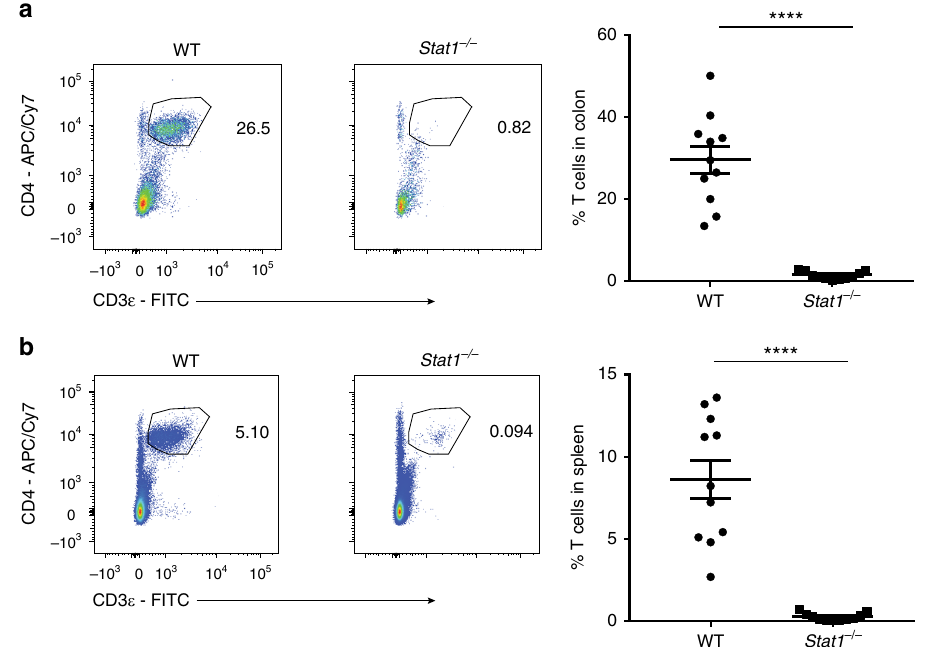
Fig. 2 Stat1 − / − T cells fail to expand in Rag1 − / − mice. Rag1 − / − mice were injected i.p. with 1 × 10 6 WT or Stat1 − / − unfractionated CD4 + T cells and analyzed 3 weeks post transfer. a , b Representative fl ow cytometry plots of CD4 + T cells (gated on live CD45 + cells) in the colon ( a ) and spleen ( b ) followed by their mean frequencies ± SEM. Data are pooled from three independent experiments, with each point representing an individual mouse. **** p